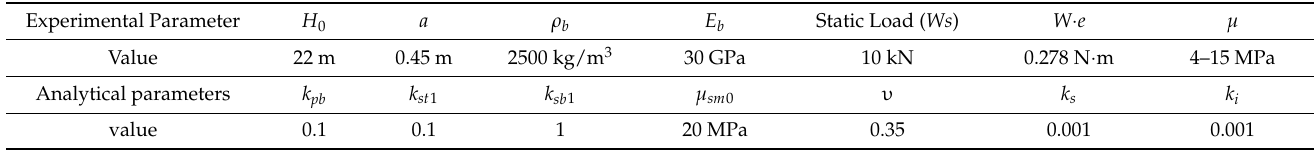
Table A1. Parameters in Figure 2b.